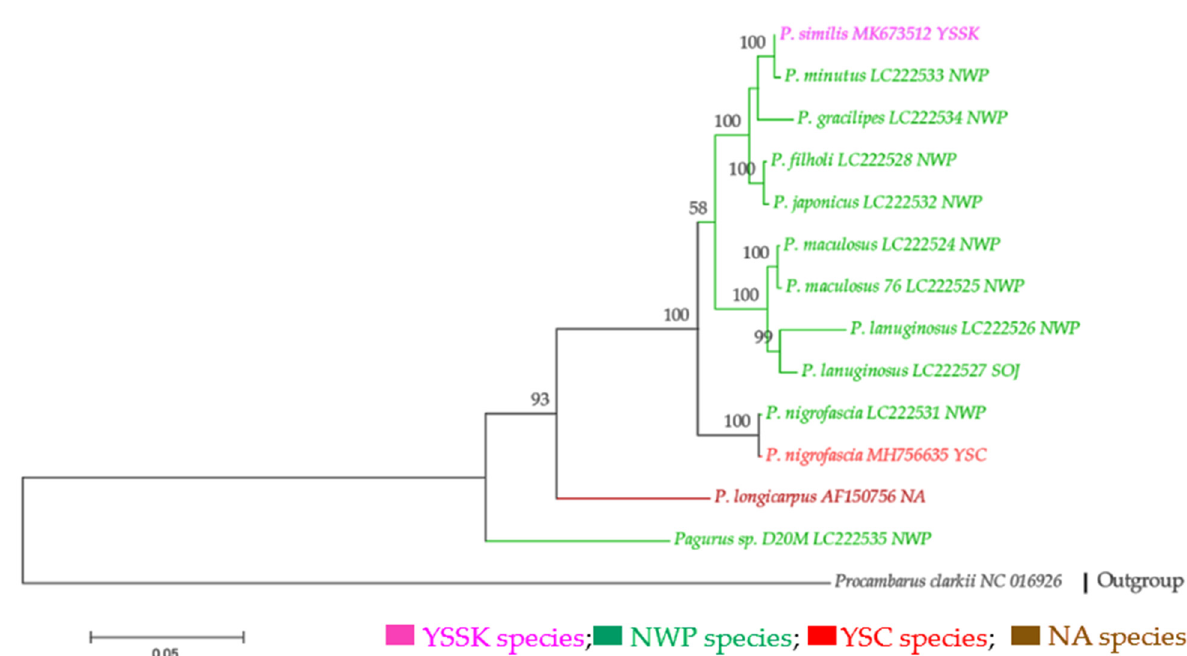
Figure 2. Maximum-likelihood (ML) tree based on mitochondrial genome (2709 amino acid) of Pagurus species with 1000 bootstrap replicates. Each sample was represented by species name, sequence accession number and the sampling location. The sampling locations included Yellow Sea South Korea (YSSK), northwest Pacific (NWP), Sea of Japan (SOJ), Yellow Sea China (YSC), and North Atlantic (NA). Different colors represent the localities of species analyzed.